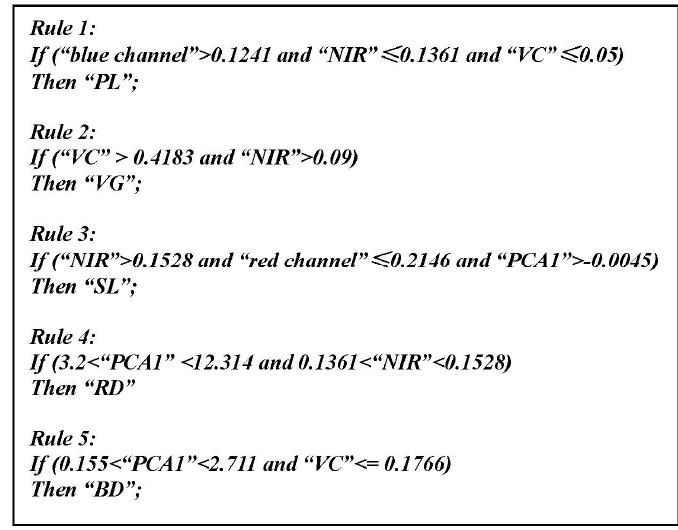
Figure 13. The final rules of the third test area (R: NIR channel; G: red channel; B: green channel).